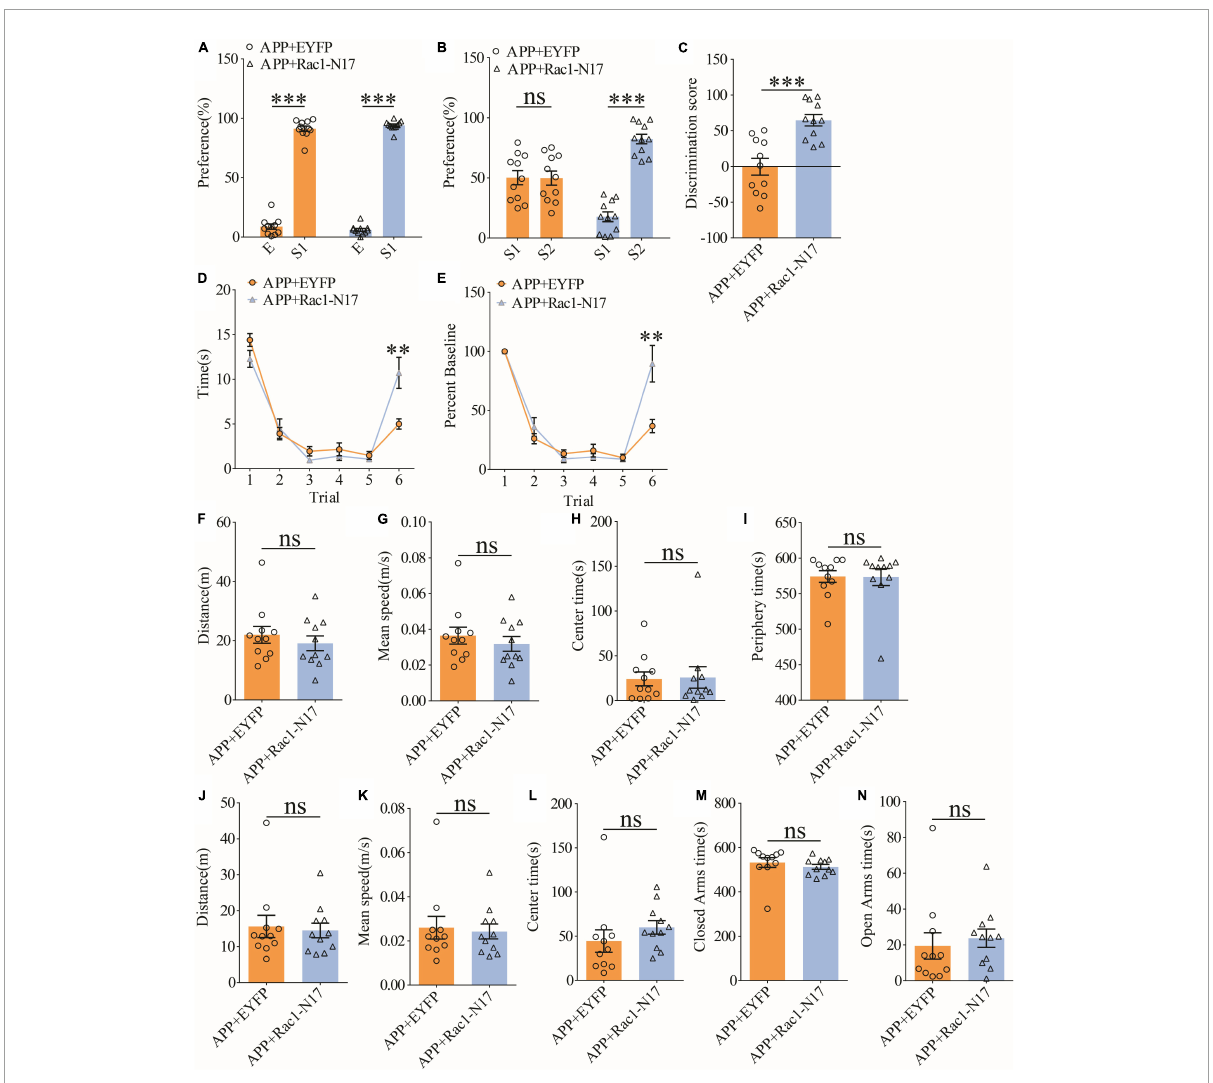
FIGURE8 Improved social memory in APP mice expressing Rac1-N17. (A) Normal sociability during stage 2 of the three-chamber social test in APP mice expressing EYFP or Rac1-N17 (APP + EYFP: n = 11, p < 0.001; APP + Rac1-N17: n = 11, p < 0.001; two-tailed paired t -test). (B) Preference for S2 over S1 during stage 3 of three-chamber social test in APP mice expressing Rac1-N17 but not in APP mice expressing EYFP (APP + EYFP: n = 11, p = 0.965; APP + Rac1-N17: n = 11, p < 0.001; two-tailed paired t -test). (C) Discrimination scores during stage 3 of the three-chamber social test showing significantly improved social memory in APP mice expressing Rac1-N17 compared to APP mice expressing EYFP ( p < 0.001, two-tailed t -test). (D) Similar performance in APP mice expressing EYFP and APP + Rac1-N17 during trials 1–5 of the five-trial social